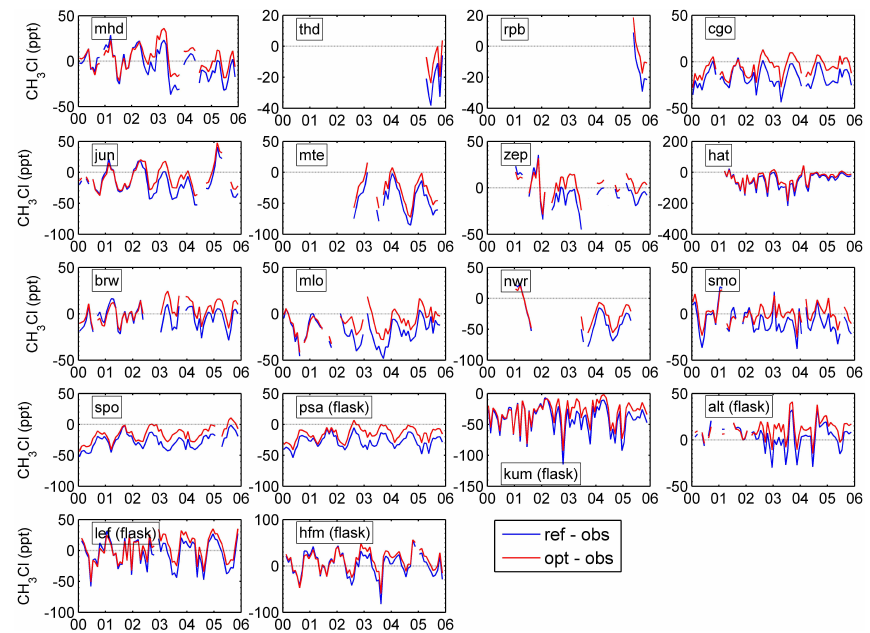
Fig. 12. Residuals between the optimized and observed monthly mean mole fractions of CH 3 Cl (red lines), compared to the residuals between the reference and observed monthly mean mole fractions (blue lines) at each observing site.